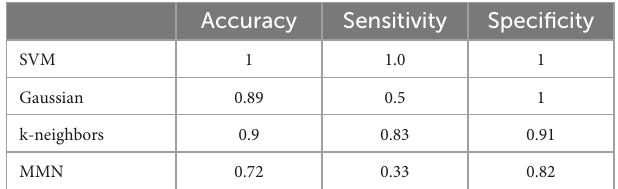
TABLE 3 Classifications